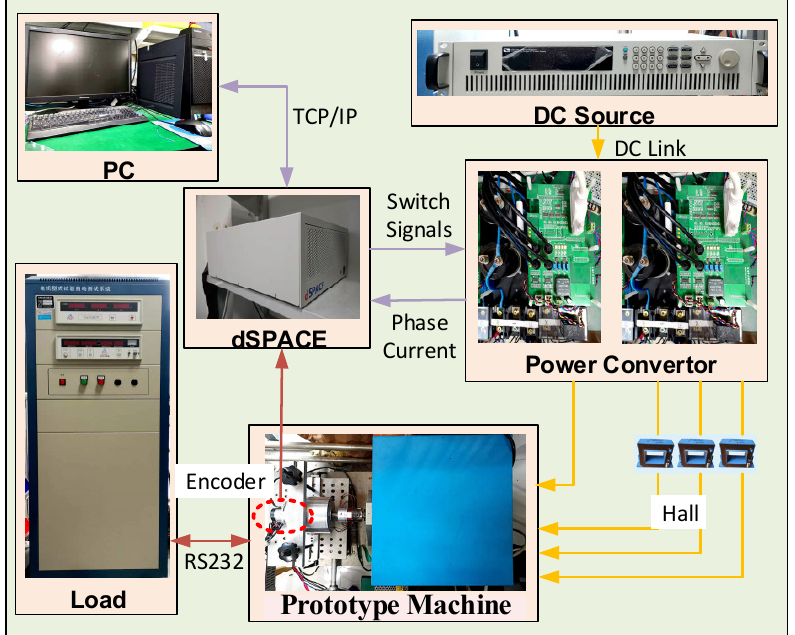
Figure 4. Experiment setup for dual three-phase PMSM drive testing. Table 1. Parameters of dual three-phase PM machine.